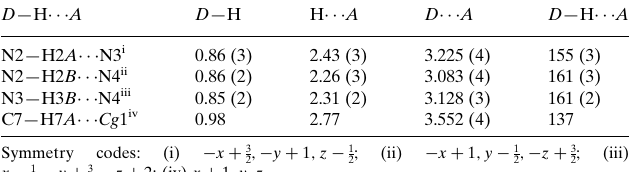
Hydrogen-bond geometry (A˚ , (cid:5)